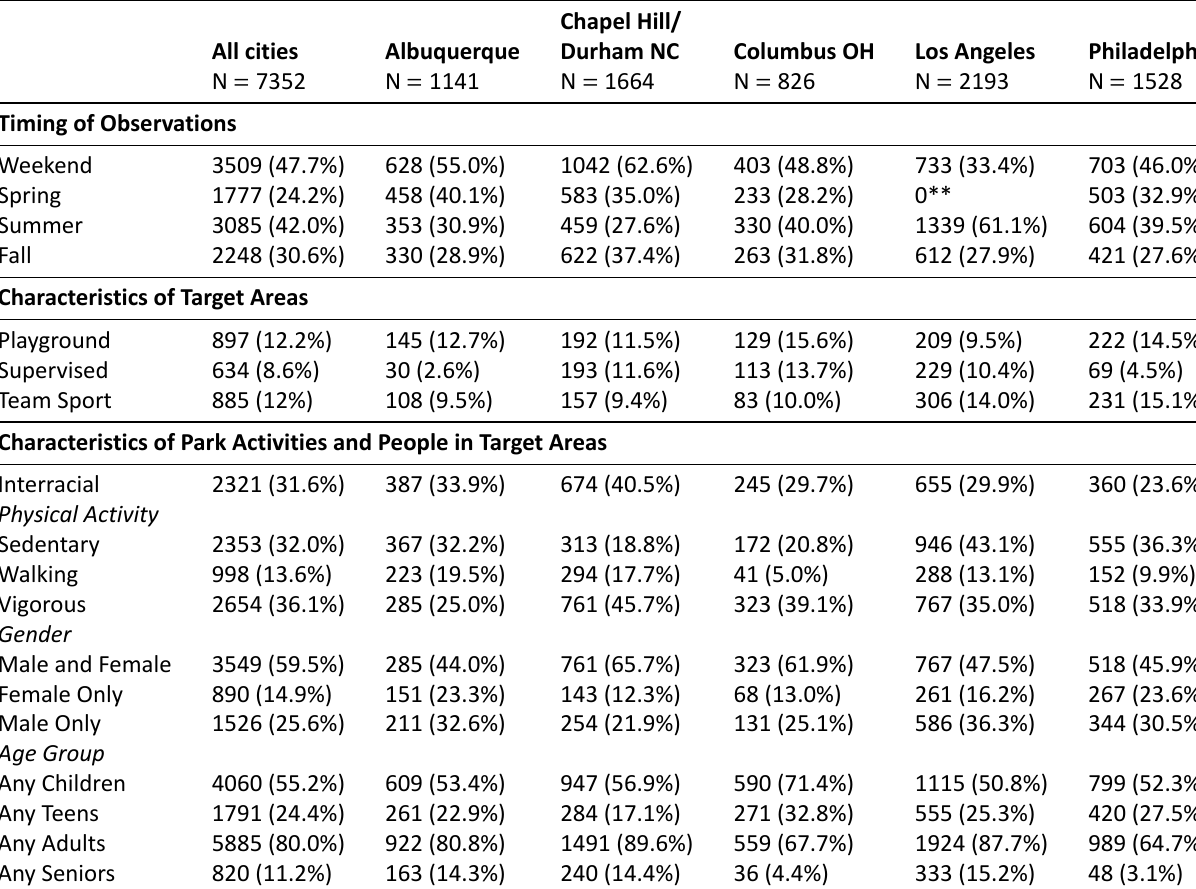
Table 1. Descriptive statistics by city for sample of park observations (N =